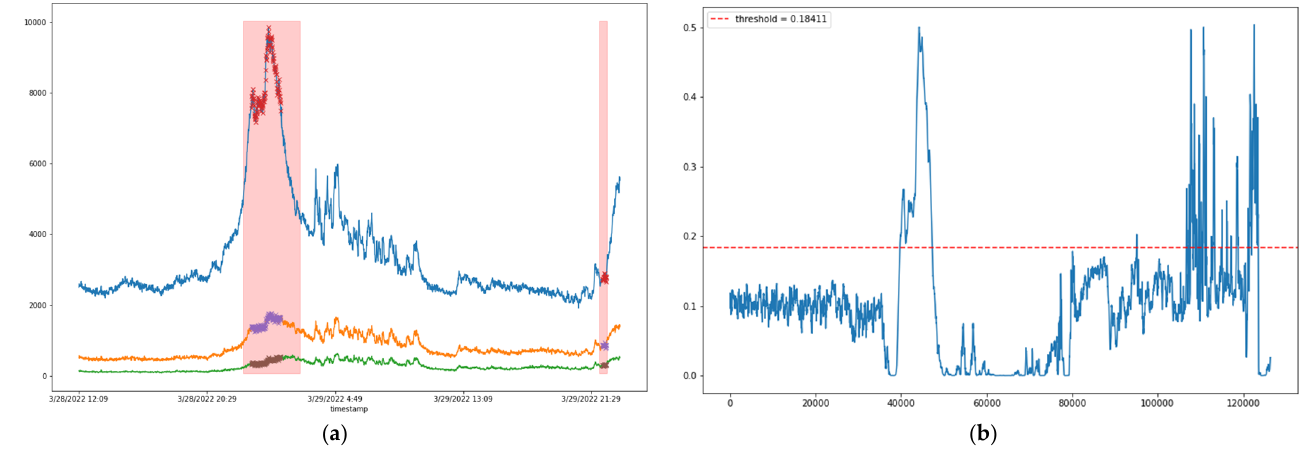
Figure 8. Anomaly detection by our SSL method for our particle ‐ matter measurement dataset. ( a ) Anomaly points with original particle ‐ matter measurement; ( b ) anomaly score with threshold.